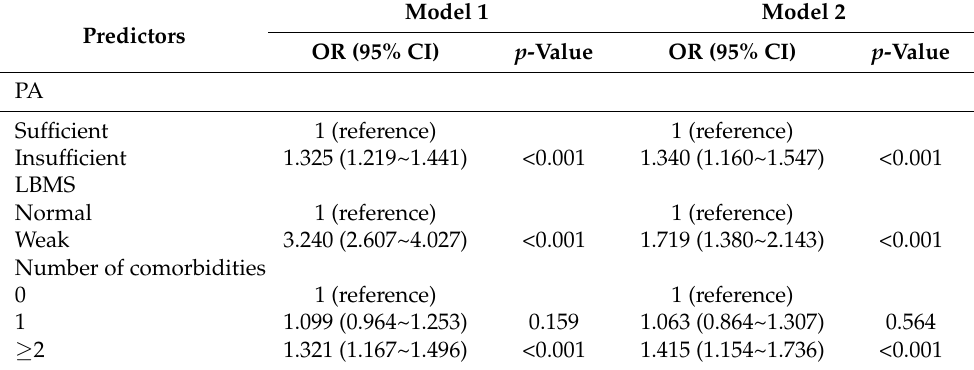
Table 3. Odds ratios (ORs) and 95% confidence intervals (CIs) of cognitive impairment by levels of physical activity (PA) and lower-body muscle strength